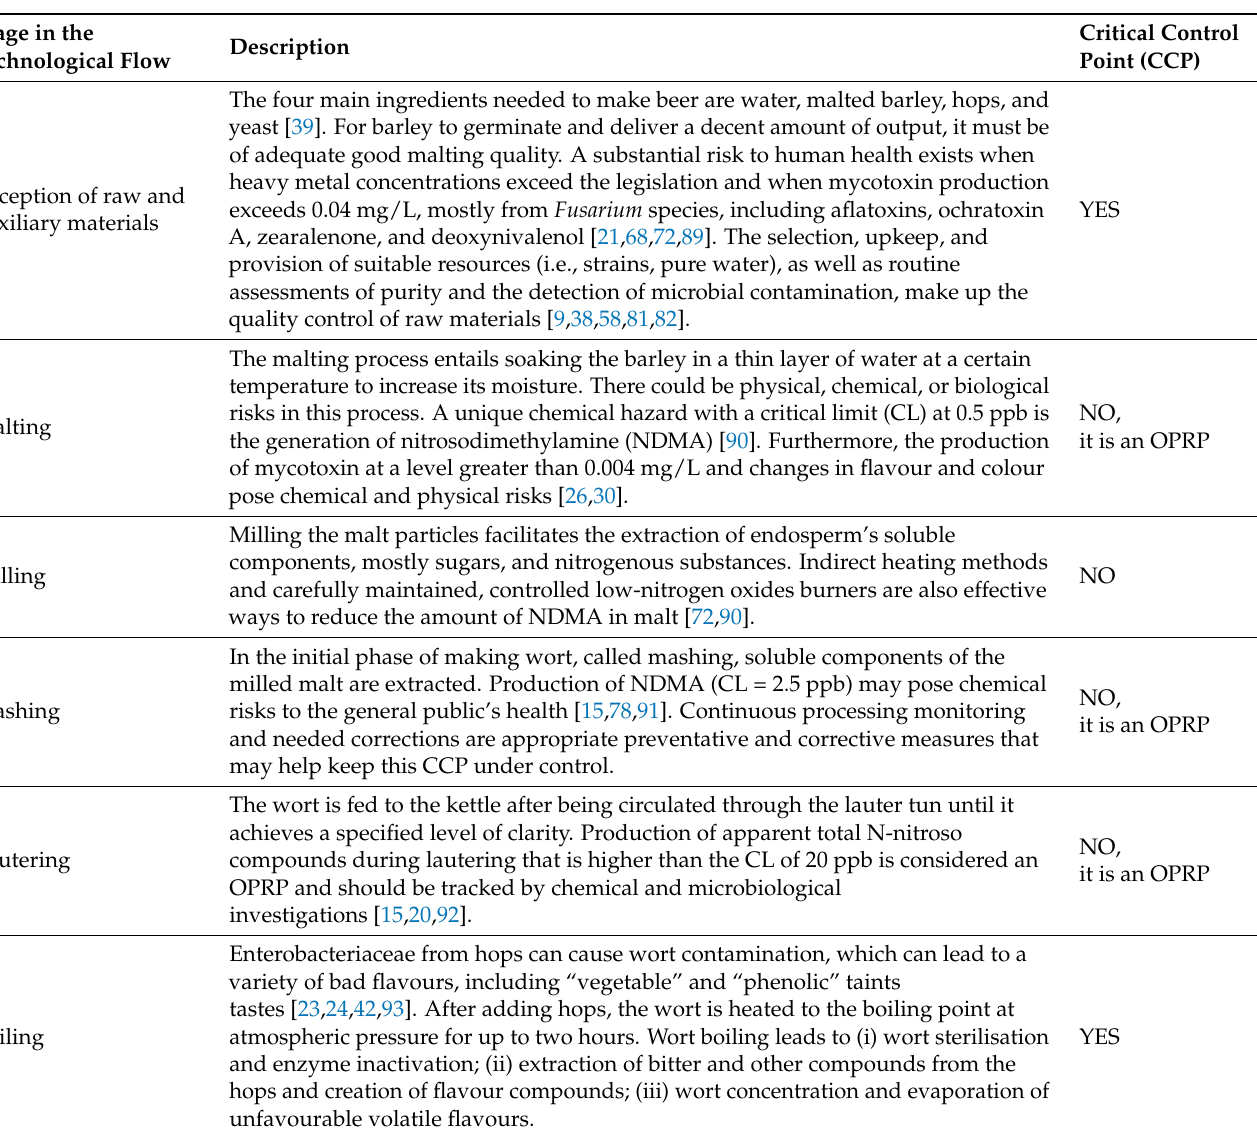
Table 4. General overview of the technological flow, hazards, and critical control points, for beer